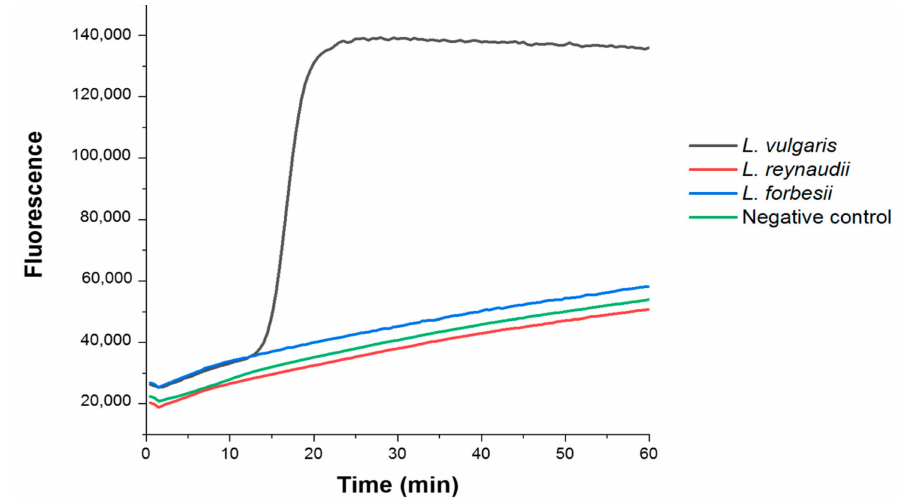
Figure 4. Fluorimetric LAMP for L. vulgaris authentication, applied on samples L. vulgaris (black line), L. reynaudii (red line), and L. forbesii (blue line).